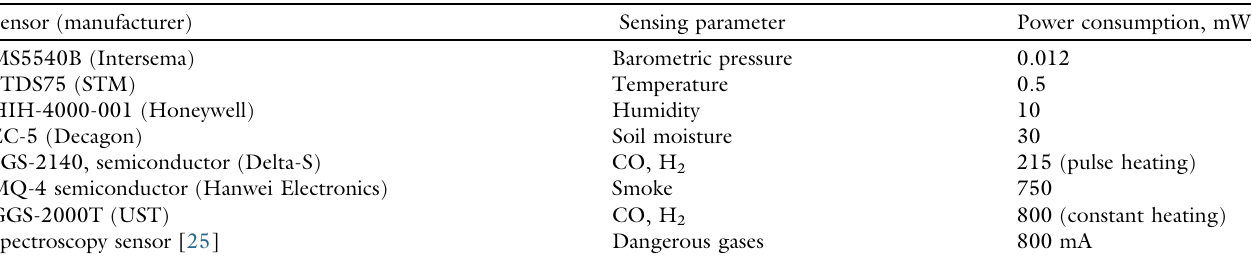
Table 2. Power consumption for some off-the-shelf sensors used for fire detection. Sensor